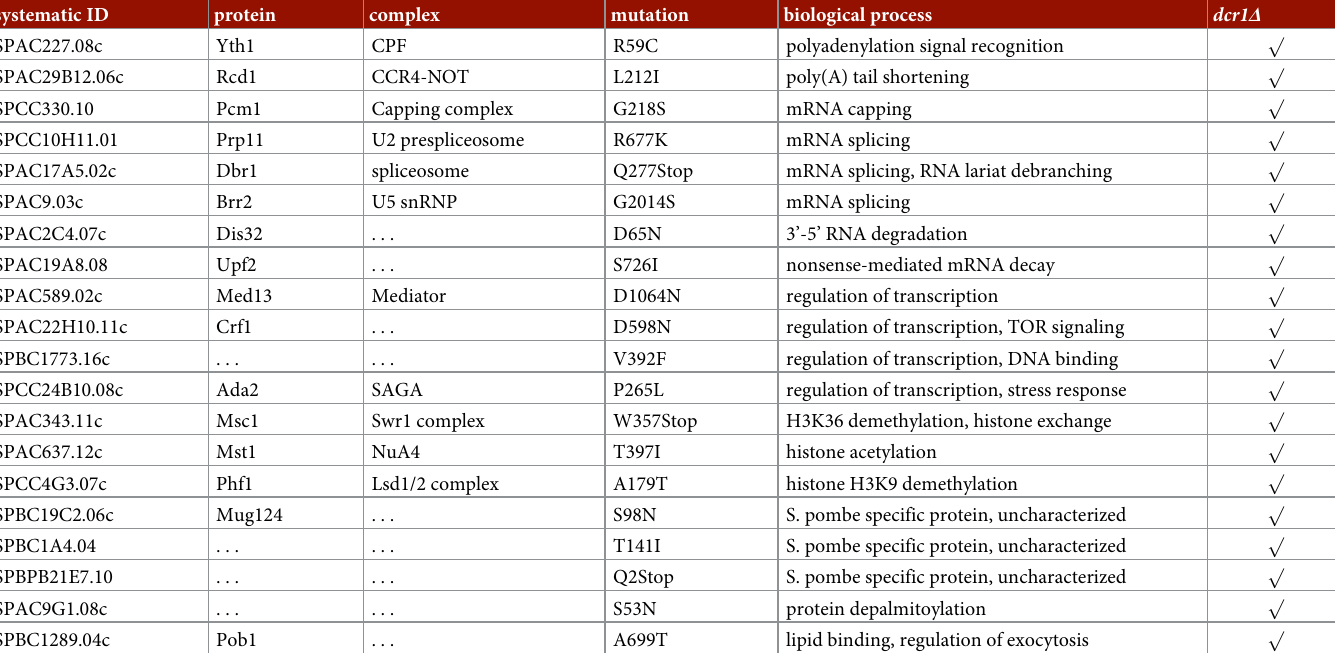
Table 2. Newly identified and validated enabling mutations. systematic